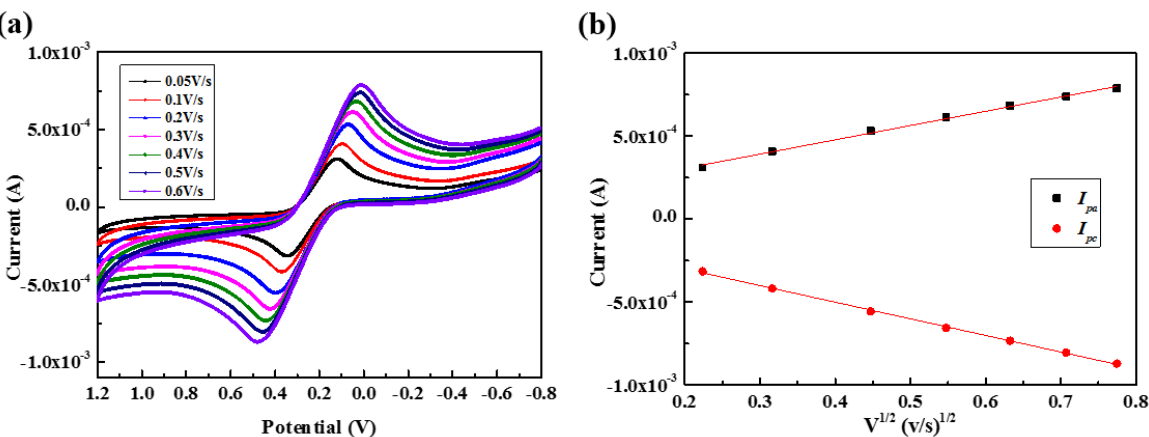
Figure 5. ( a ) Cyclic voltammograms of 4mM [Fe(CN) 6 ] 3 − /4 − for a F-MWCNT/MWCNT/PDMS electrode with scan rates from 0.05 to 0.6 V/s and ( b ) anodic and cathodic peak currents ( I pa and I pc , respectively) as a function of square root of the scan rates ( ν ).